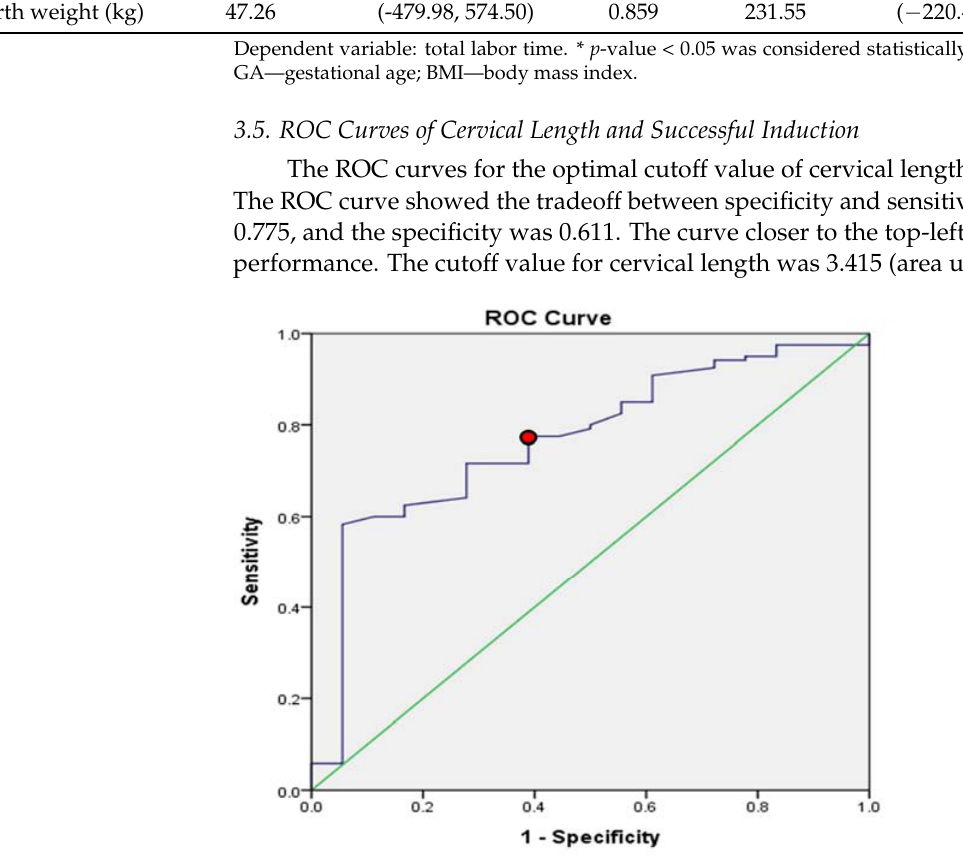
Table 4. Factors associated with total labor time (n = 138).